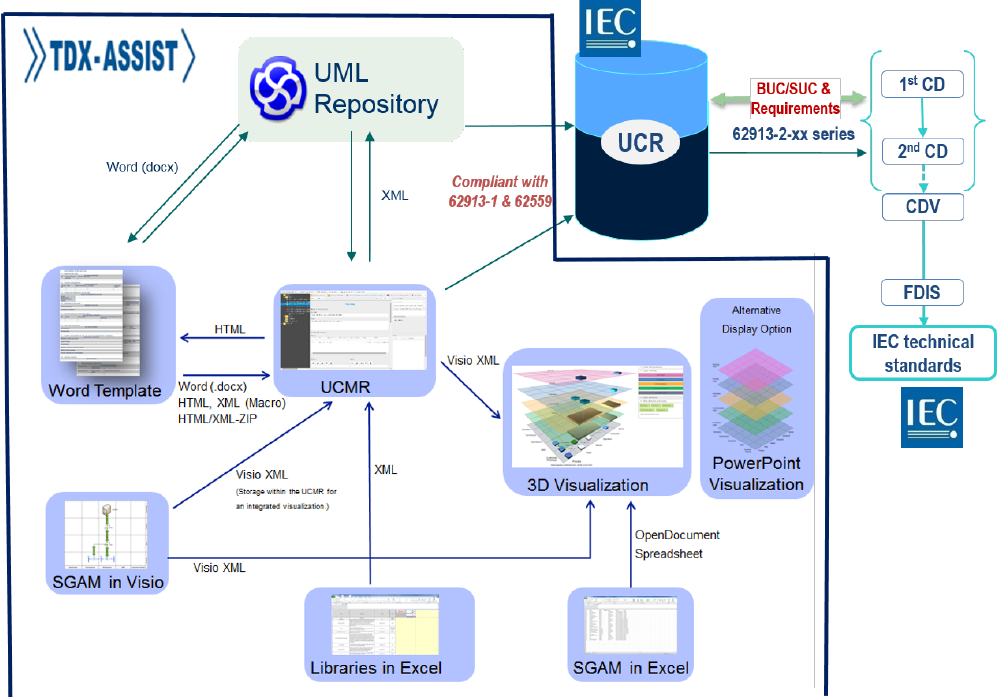
Figure 11. Toolchain used in H2020 TDX-Assist (source: